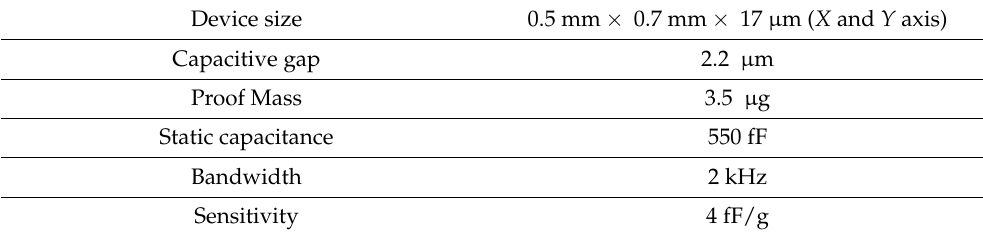
Figure 14. Readout chip based on the RNSF technique tested with a femto-farad MEMS accelerometer. ( a ) Test environment; ( b ) Photography of the chip bonded with the MEMS accelerometer. Table 2. Specifications of the MEMS capacitive